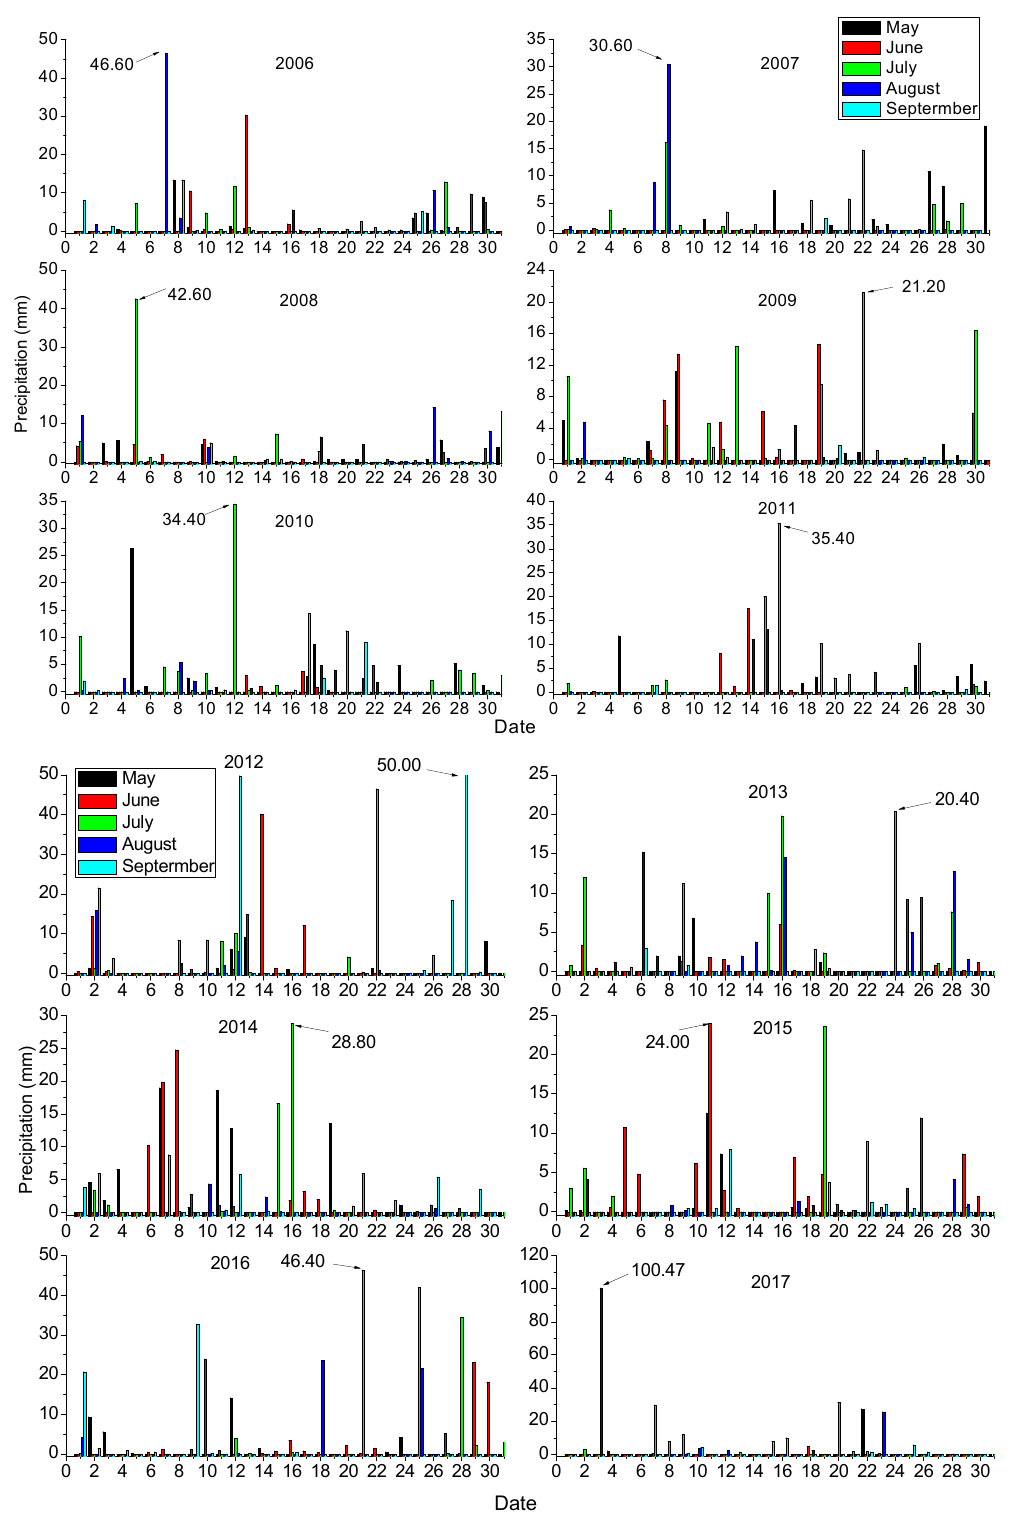
Figure 3. The mean precipitation diurnal variations during maize growing season (from May to September) in experimental fields at the Naiman Desertification Research Station of the Chinese Academy of Sciences, Naiman, China, from 2006 to 2017.